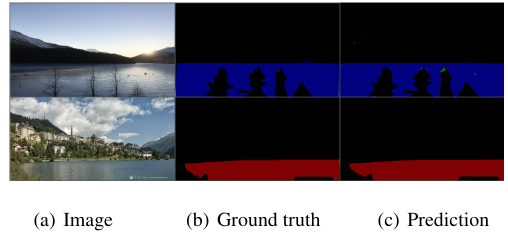
Figure 14: Lake ice segmentation on crowd-sourced